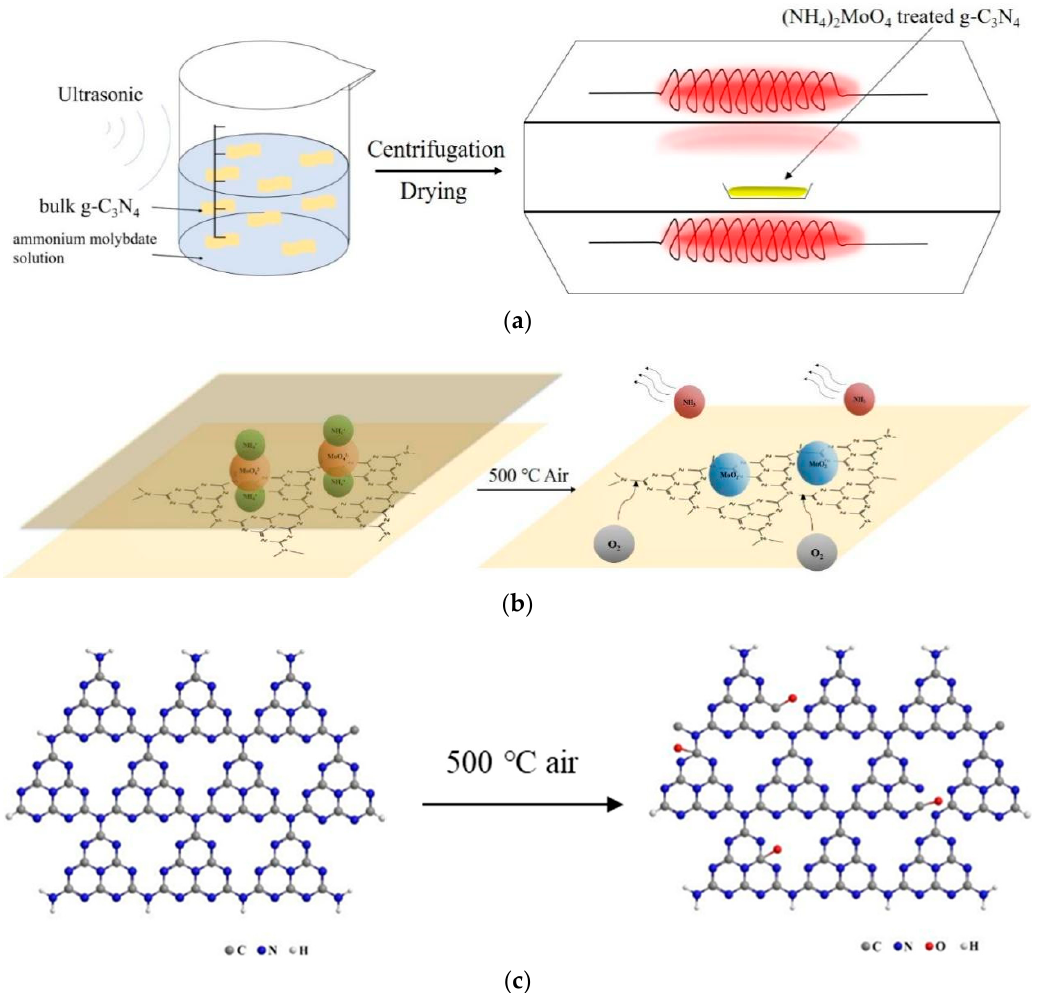
Figure 5. Schematic diagrams of ( a ) the synthesis strategy for the samples, ( b ) the formation mechanism for the exfoliated g-C 3 N 4 /MoO 2 composite, and ( c ) the oxidation mechanism for g-C 3 N 4 .